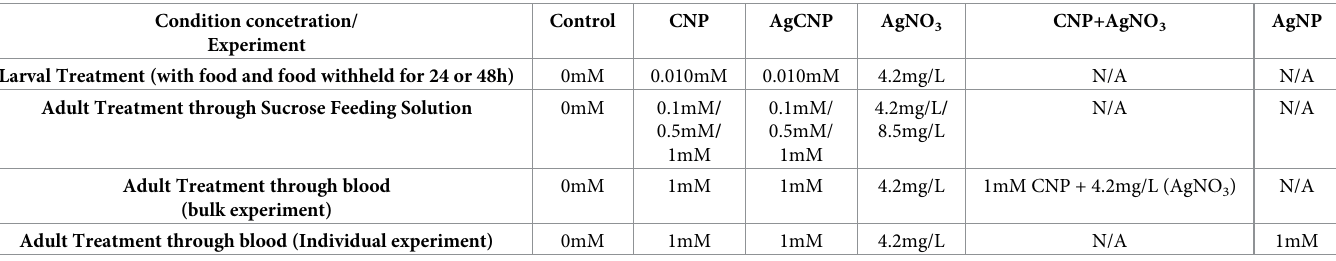
Adult Treatment through blood 0mM N/A (bulk experiment) Adult Treatment through blood (Individual experiment)